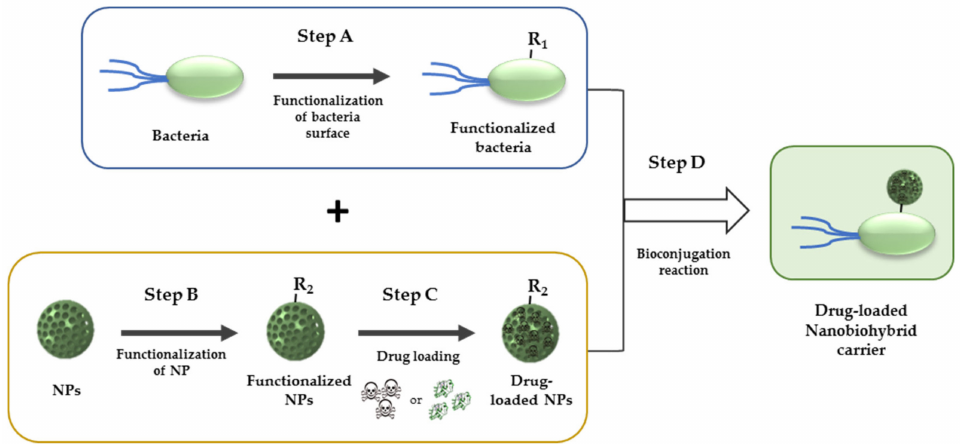
Figure 5. General scheme of bioconjugation reactions for the obtention of a drug-loaded nanobio- hybrid carrier. Step A: First, a chemical group R 1 is incorporated in the surface of bacteria. Step B: Nanoparticles are functionalized with the chemical partner of R 1 (R 2 ). Step C: Then, NPs are loaded with the desired therapeutic agent. Step D: Bioconjugation reaction between the chemical partners R 1 and R 2 leads to the bioconjugate